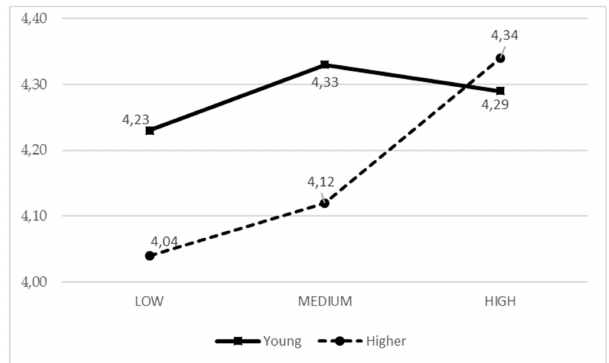
Figure 2. Means of the IPAF2 parental style based on the adolescent age for